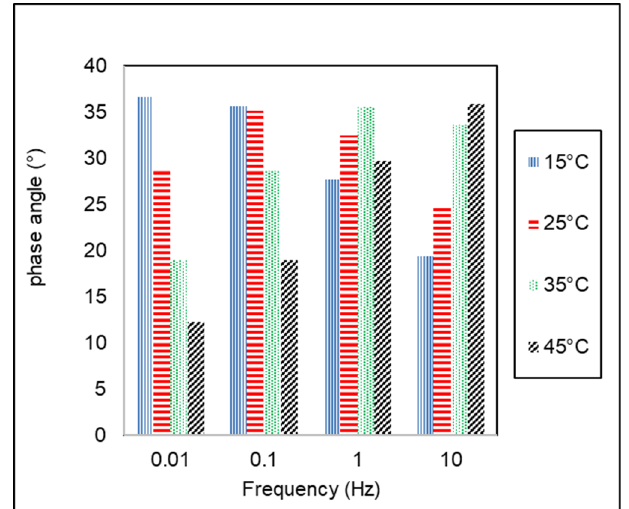
Figure 8. Variation of phase angle of AC-WC with temperature and frequency.